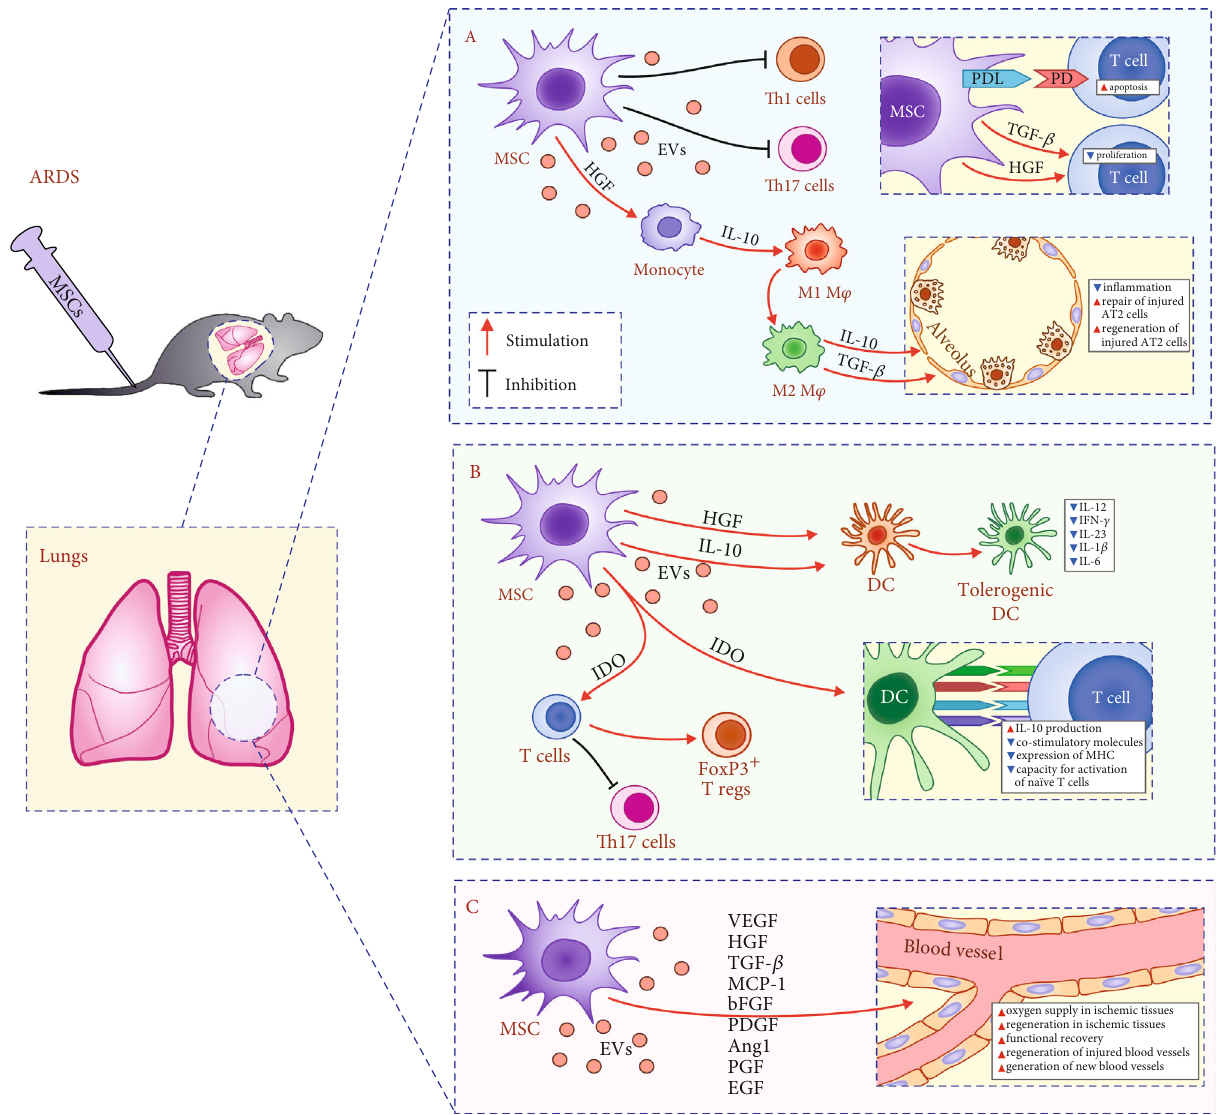
Figure 2: Molecular mechanisms responsible for MSC-based attenuation of ARDS. MSCs, in juxtacrine (cell-to cell-contact dependent) and paracrine manner (through the production of immunomodulatory factors), alleviate lung in fl ammation and ARDS by suppressing proliferation and e ff ector functions of in fl ammatory M1 macrophages and Th1 and Th17 cells (a) and by inducing generation of tolerogenic DCs and expansion of immunosuppressive Tregs (b). Through the production of angiomodulatory factors, MSCs improve oxygen supply enabling enhanced regeneration and functional recovery from